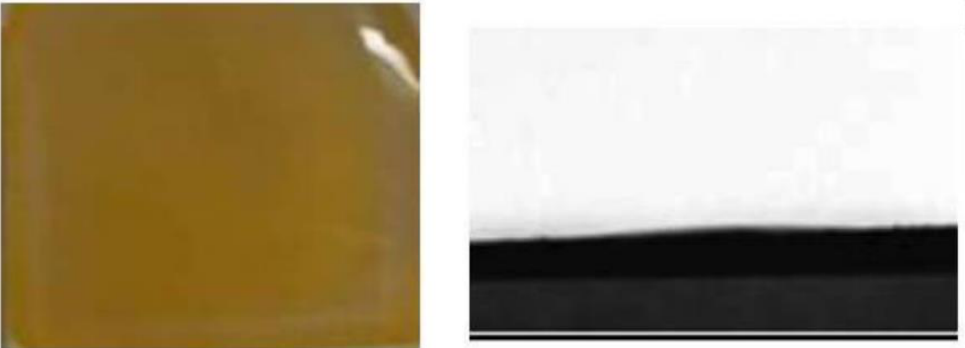
Figure 10. The photo and contact angles of the PbBr 2 /thiourea layer for the CsBr/H 2 O solution [52]. He’s group [53] added a self-polymeric monomer of N-(hydroxymethyl) acrylamide (HAM) containing C=C, C=O, and -NH multifunctional groups in CsBr aqueous solution to prepare CsPbBr 3 PSCs using a two-step method. The best power conversion efficiency of the cell was 9.05%. Adding HAM additive to CsBr aqueous solution to prepare CsPbBr 3 cells was able to not only retard the crystallization, but also to regulate the band structure of the CsPbBr 3 layer and simultaneously passivate its defects. Moreover, the device main- tained over 92% of its initial efficiency value after 30 days of storage in ambient air under highly humid conditions or at high temperature, demonstrating significant stability. 5. All-Green Solvent Systems In the above-mentioned research ideas, PbBr 2 films were first spin-coated onto sub- strates from PbBr 2 /DMF solution, and then the CsBr green solution was spin-coated on the prepared PbBr 2 layer to create CsPbBr 3 film. It appears that our only option is to adopt toxic DMF in the first step during the prep- aration of perovskite films due to the low solubility of PbBr 2 in green solvent. However, if the human body is exposed to an environment containing high levels of DMF, it can cause a lot of harm, especially to the human liver [32]. Thus, it is necessary to develop an all-green solvent system to prepare CsPbBr 3 PSCs to guarantee the health of humans. Generally, there are two ways to prepare CsPbBr 3 PSCs in all-green solvent systems. The first method is to prepare PbBr 2 films with a two-step spin-coating method, followed by reacting with CsBr aqueous solution. Wei’s [64] group created an innovative method to realize the eco-friendly manufacture of CsPbBr 3 films using water to dissolve precursors of Pb(NO 3 ) 2 and CsBr, and using IPA to dissolve phenethylammonium Bromide (PEABr), as shown in Figure 11. In this method, only the two green solvents of water and 2-propa- nol (IPA) were used to prepare CsPbBr 3 PSCs with a champion PCE of 6.25%. When kept at room temperature for 30 days with a relative humidity of 40%, the device maintains 94% of initial PCE, showing the superb stability of CsPbBr 3 cells. This work described good previous experience for the eco-friendly manufacture of CsPbBr 3 PSCs, and reduces the manufacturing cost of the CsPbBr 3 PSCs. Furthermore, this innovative method for prepar- ing CsPbBr 3 film is entirely different from the frequently used multi-step spin-coating method, and is very instructive for the preparation of CsPbBr 3 PSCs. However, the PCE of CsPbBr 3 solar cells prepared by this method is relatively low.